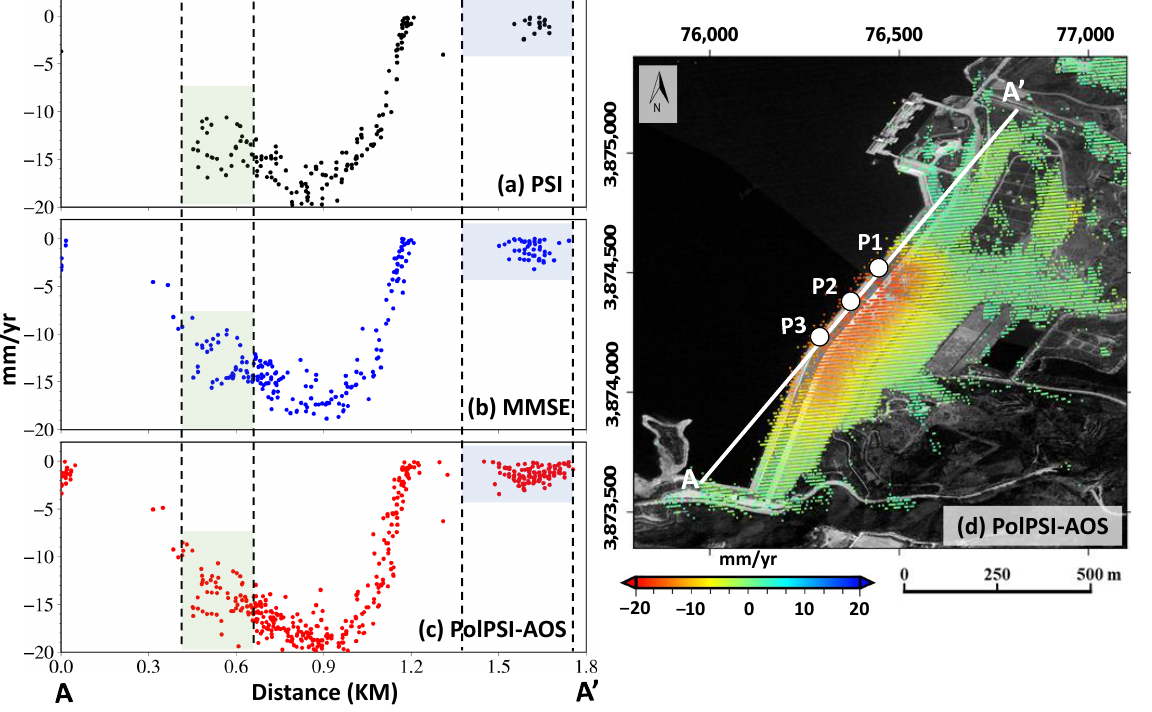
Figure 15. The selected pixels along with a profile (from A to A’) over the XiaoLangDi obtained by the ( a ) PSI, ( b ) MMSE, and ( c ) PolPSI-AOS, respectively. The location of the profile is shown in ( d ) by the white line over the PolPSI-AOS retrieved displacements. The three filled dots in ( d ) indicate locations of the pixels selected for time-series deformation analysis in Figure 16. It is worth to note that ( d ) is in UTM (Universal Transverse Mercator)